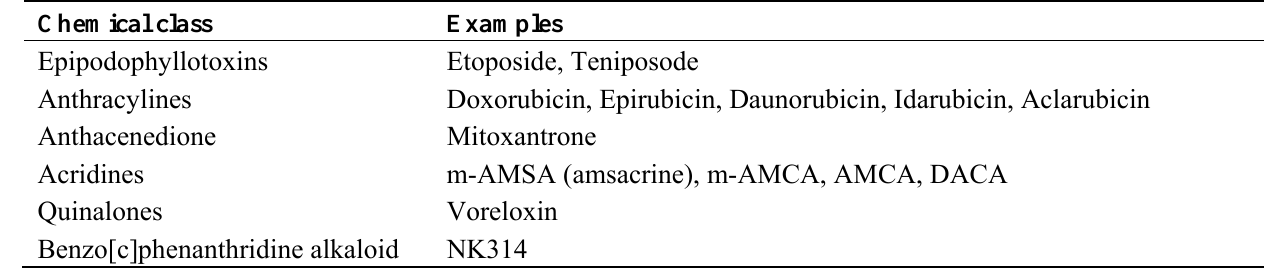
Table 2. TOP2 poisons, those that are or have been used clinically in cancer therapy are in